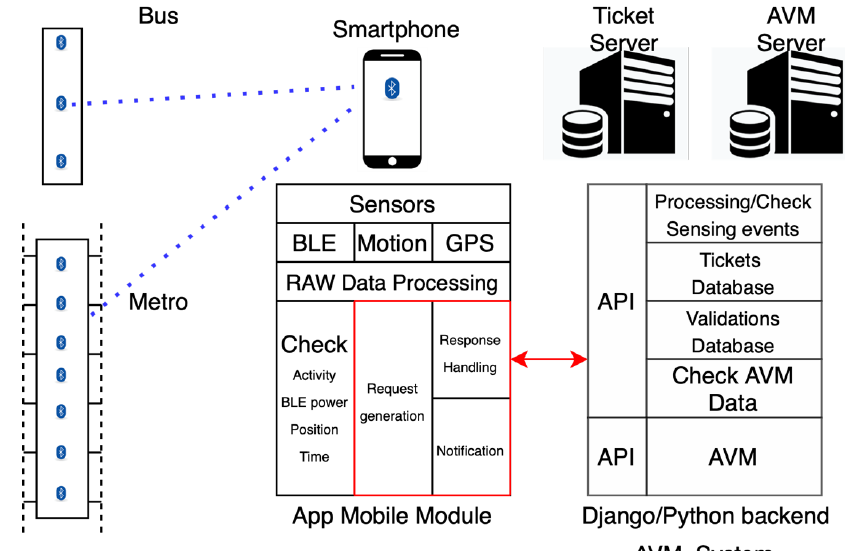
Figure 7. Complete system